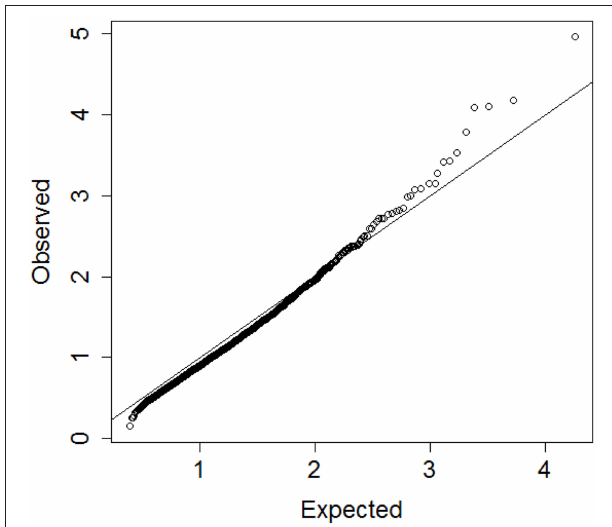
FIGURE 6 | QQplot of the observed heights of the branch nodes in the dendrogram of hierarchical clustering of 4704 profiles of 19 biomarkers in participants of the Long Life Family Study (y-axis) and the expected heights based on 10 resampling of the data. The departure from the diagonal line suggests that there are significant clusters in the